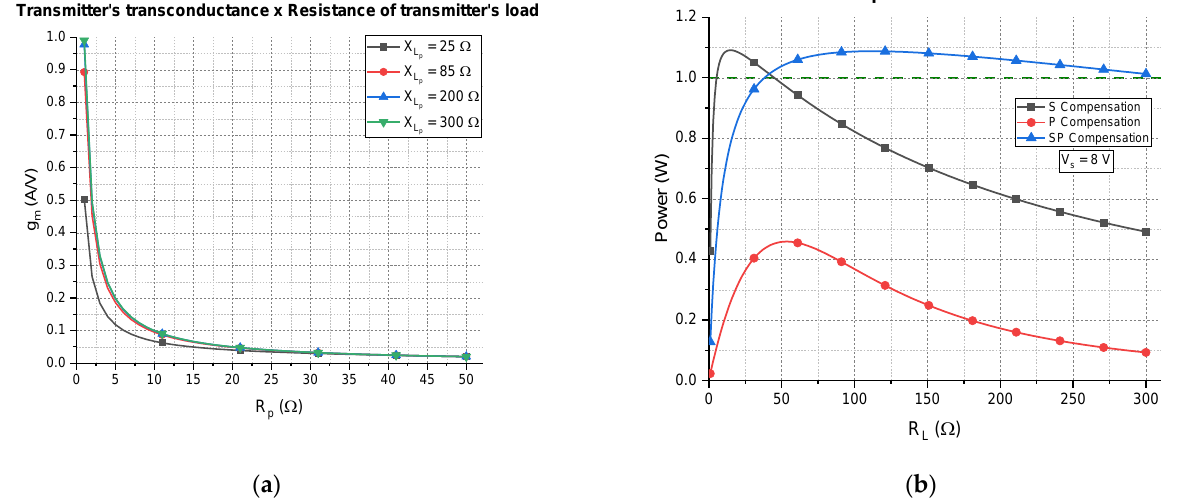
Figure 13. ( a ) Theoretical transmitter’s transconductance vs. resistance of the transmitter’s load for four values of reactance of the transmitter’s load. ( b ) Delivered power to the receiver’s load vs. receiver’s load for the three types of compensation and the sinusoidal voltage supply set to 8 V of amplitude.